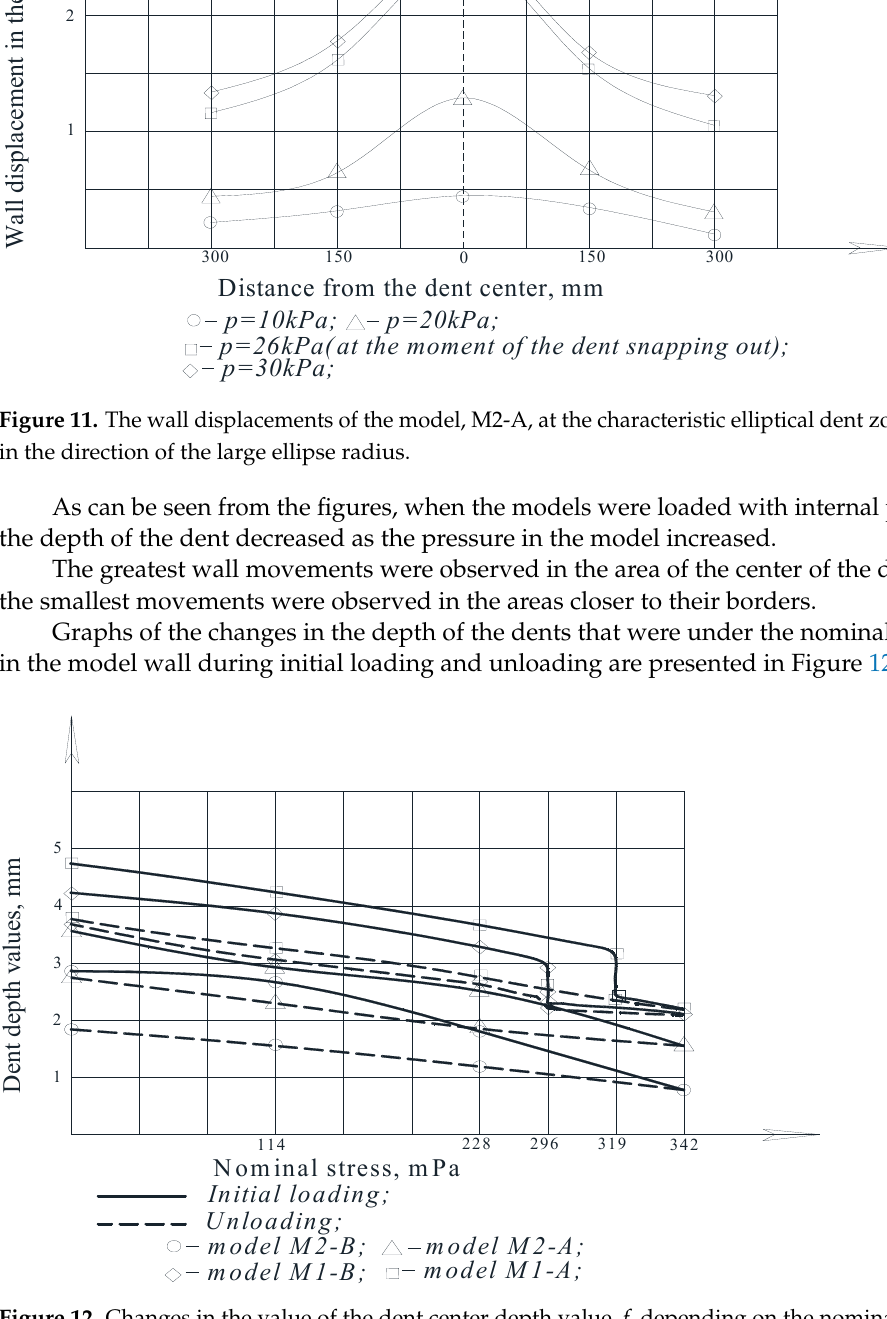
Figure 12. Changes in the value of the dent center depth value, f, depending on the nominal stresses σ n [34].